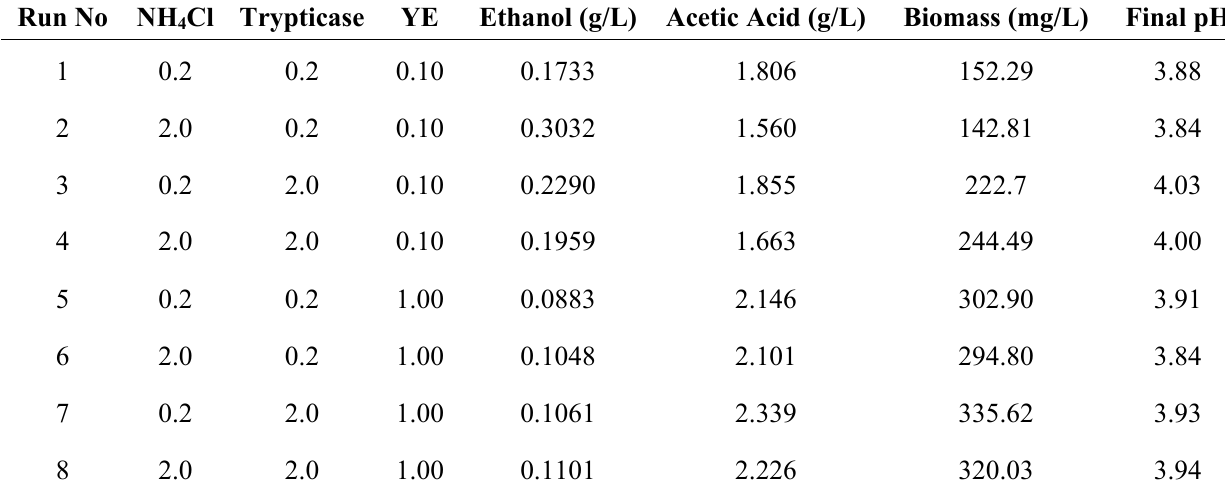
Table 1. 2 3 Factorial design table of experiments and